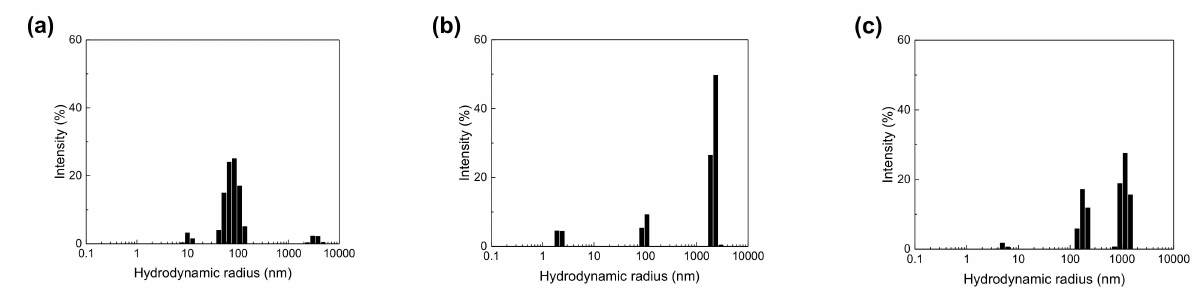
Figure 3. Hydrodynamic radius ( R H ) distribution determined by DLS measurements of ( a ) 0.1 wt % PEO/MeOH solution, ( b ) 10 wt % Nafion/MeOH dispersion, and ( c ) 10 wt % Nafion–0.1 wt % PEO/MeOH